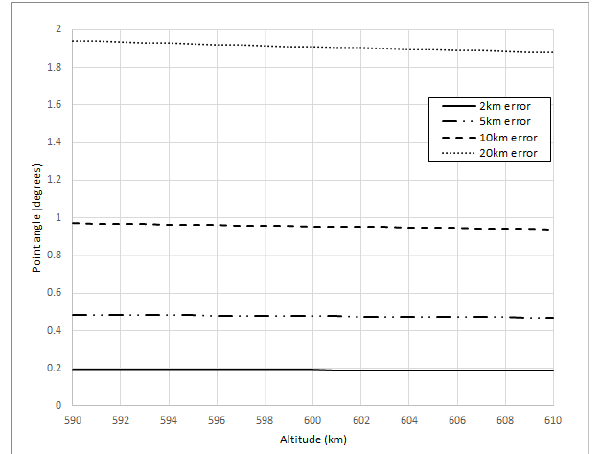
Figure 11. Pointing angle variation on different